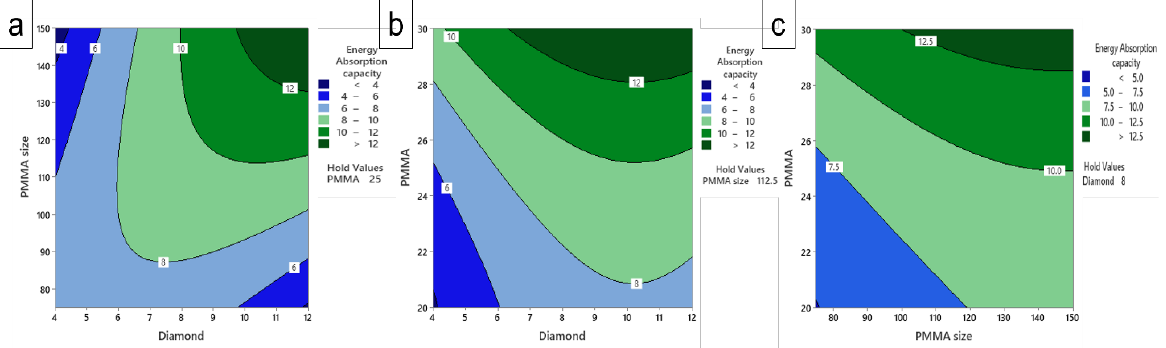
Figure 14. Contour plot of energy absorption capacity of, ( a ) PMMA size vs. diamond content ( b ) PMMA vs. diamond content and ( c ) PMMA size vs. PMMA content. ( b ) PMMA vs. diamond content and ( c ) PMMA size vs. PMMA